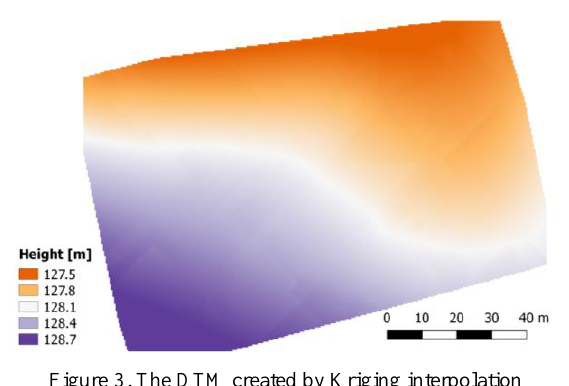
Figure 3. The DTM created by Kriging interpolation